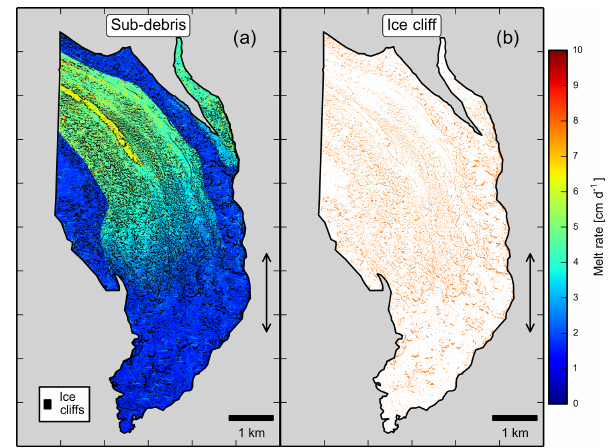
Figure 11. Distributed melt rates based on elevation and flow path (medial moraines). The zone of maximum thinning (ZMT) is de- fined by the double-headed arrows in each panel. (a) The best sub- debris melt rate estimate which decreases in magnitude downglacier in the central part of the glacier. Medial moraines near the edge of Kennicott Glacier were composed of thicker debris. (b) The best ice cliff backwasting rates which we assume are uniformly dis- tributed across the study area with a value of 7.1cmd − 1 . Note that no clear trends were present in ice cliff backwasting rate from me- dial moraine to medial moraine so the same backwasting–elevation relationship is applied across the study area (Fig.